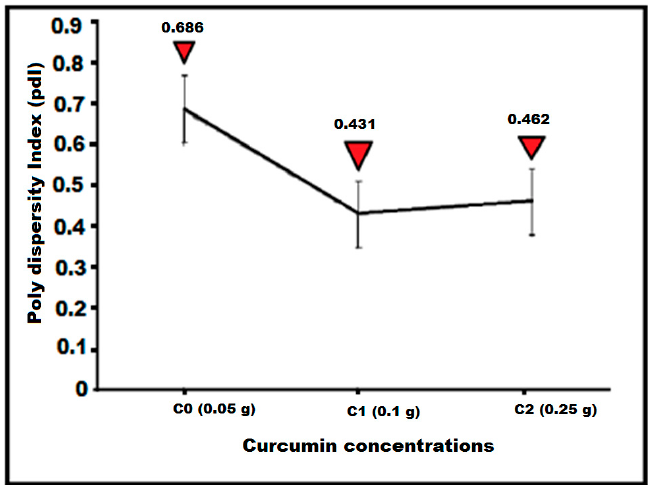
Figure 4. Polydispersity index (pdI) for various concentrations of curcumin, i.e., Curcumin, C0, C1, and C2. and